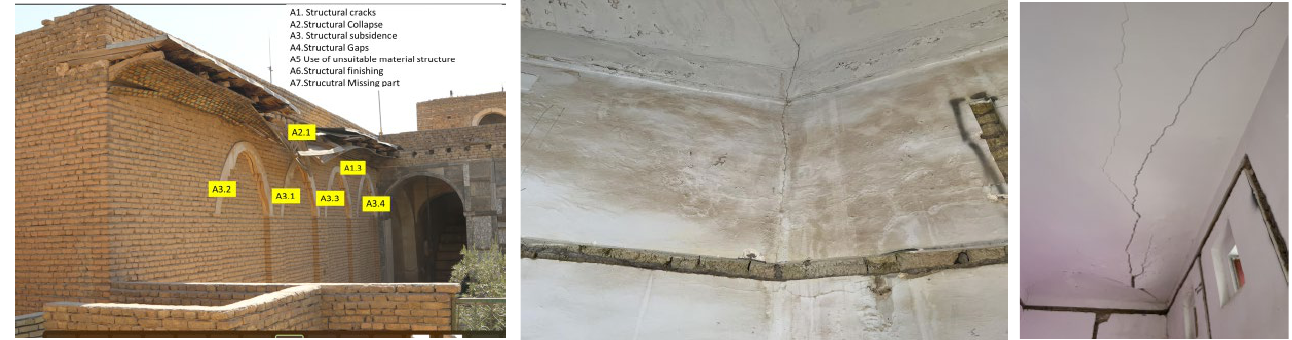
Figure 14 . Diagnosis of the defaults and cracks in the ceilings and envelop after the refurbishment process by author.